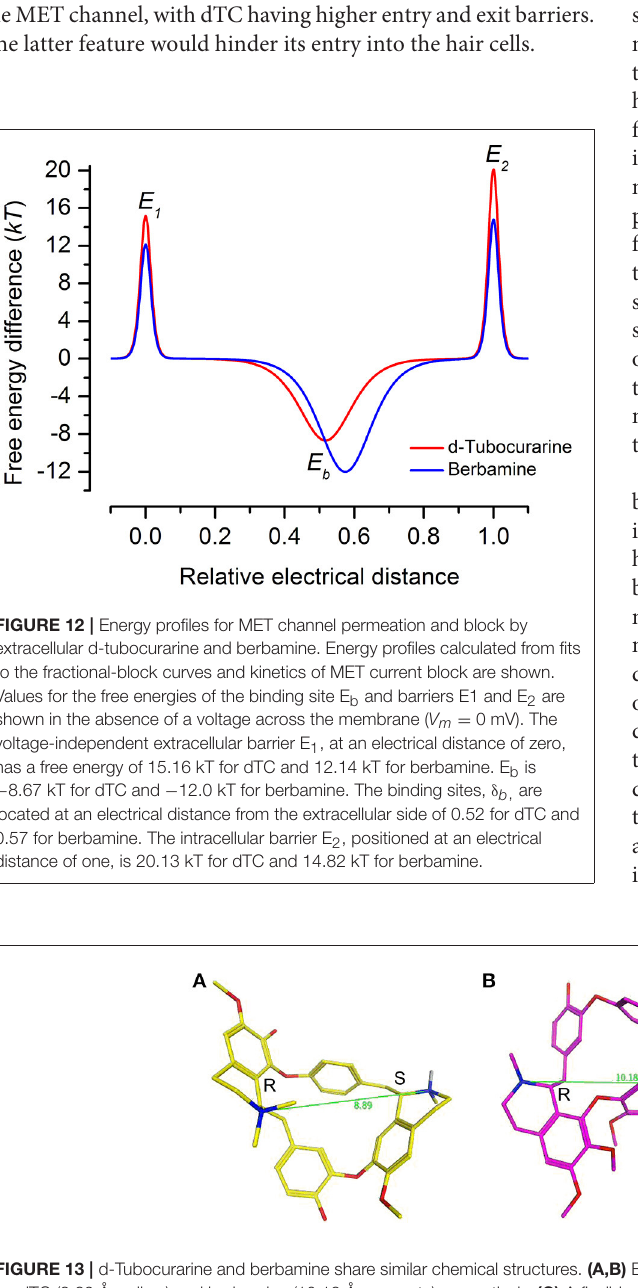
FIGURE 13 | d-Tubocurarine and berbamine share similar chemical structures. (A,B) Energy-minimized structures showing the distance between the positive charges for dTC (8.89 Å; yellow) and berbamine (10.18 Å; magenta) respectively. (C) A flexible alignment with the structures not minimized reveals dTC and berbamine share striking structural